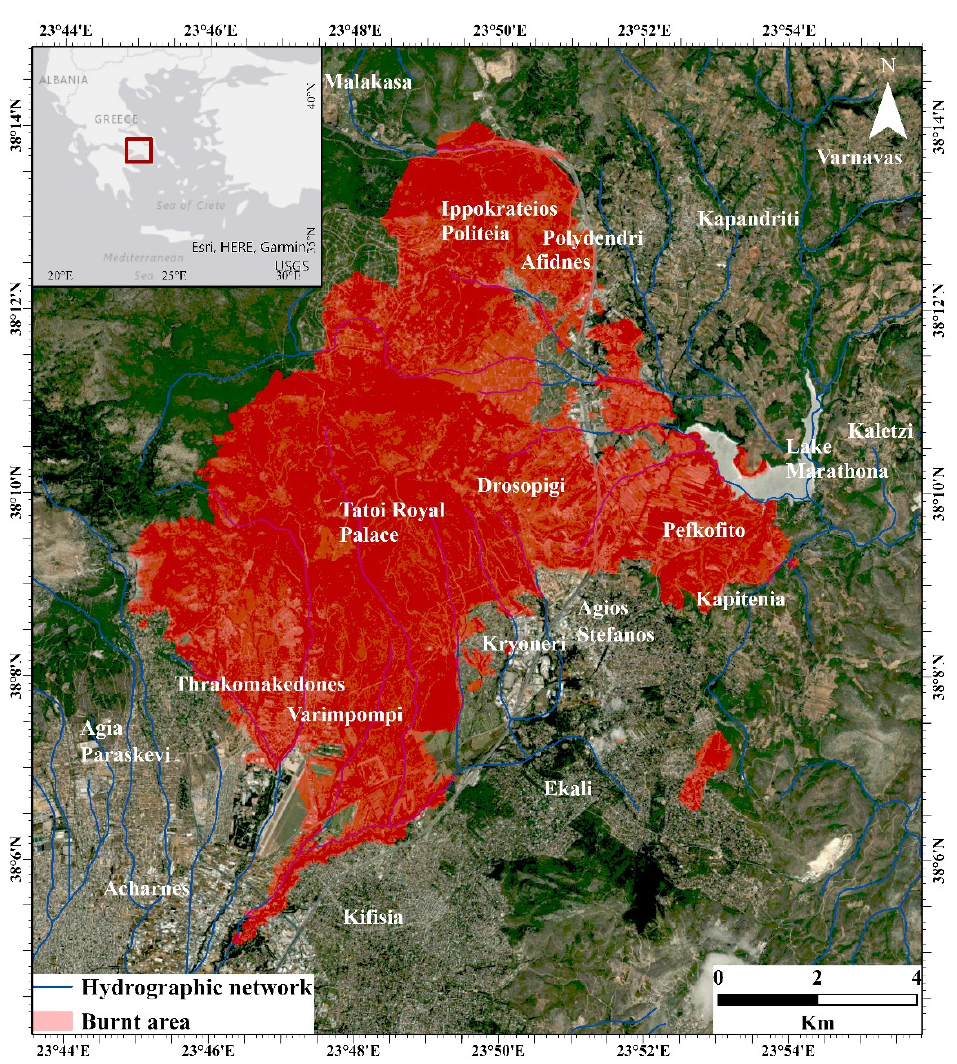
Figure 2. Areas affected in the wider area of Athens. The map is also available in web map view through the URL https://arcg.is/1bqz1i .(accessed on 15 May 2022)